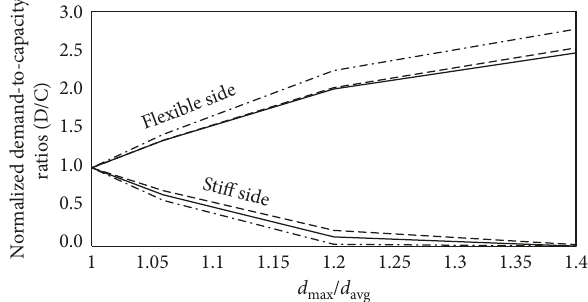
Figure 14: Normalized demand to capacity ratios D/C, calculated by means of nonlinear dynamic analyses, at varying δ max / δ avg provided by equivalent linear static analysis. Comparison between the inelastic response of the column placed on the stiff side and that provided by the column on the flexible